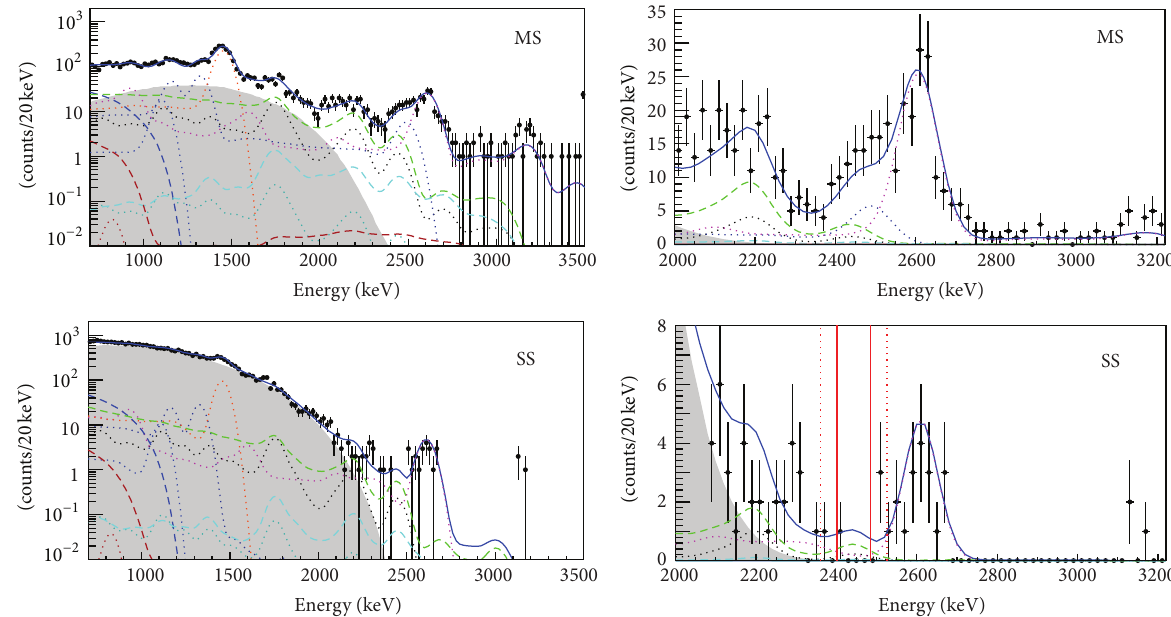
Figure 4: The EXO data [27] showing the multisite events and the single site events. The best fit is shown in blue, while the background components are as follows: grey: 2 ] 𝛽𝛽 ; dotted orange: 40 K; dark blue: 60 Co; green, cyan and black are 238 U (mainly 214 Bi) on the air gap, TPC vessel, and cathode, respectively; dotted magenta: 232 Th in the vessel.